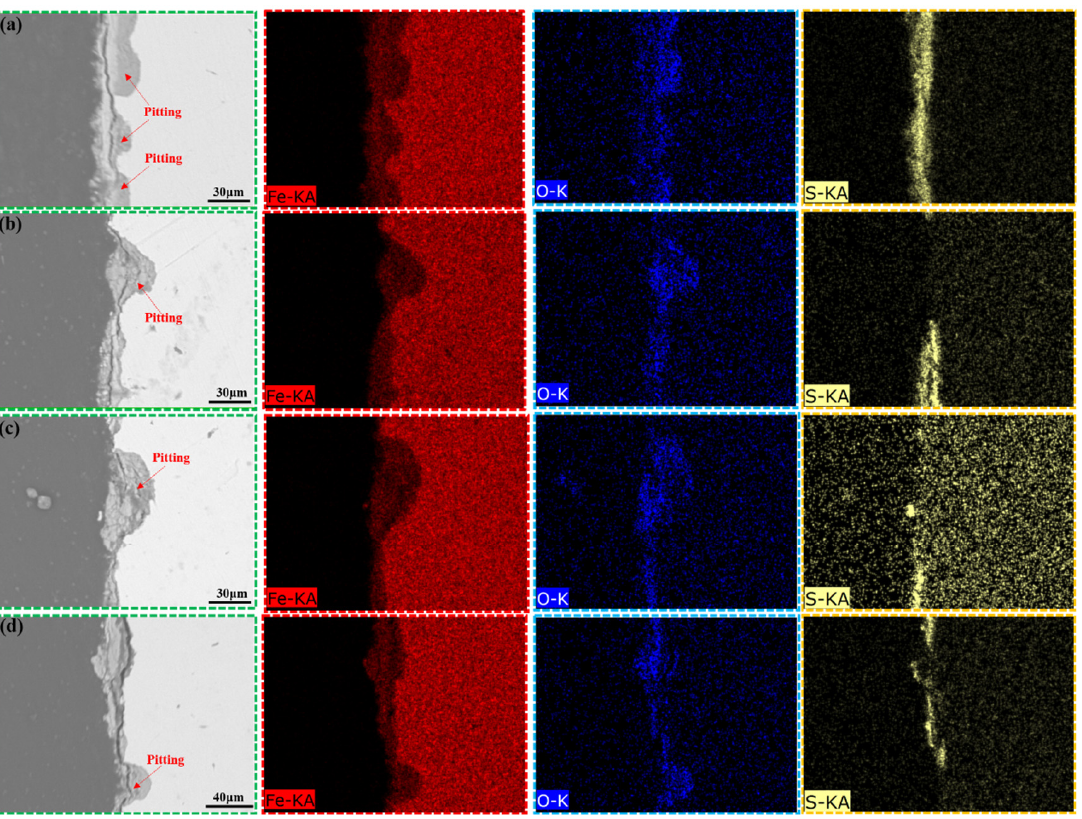
Figure 14. Element distribution in the pitting of T95 steel corroded in the liquid phase ( a ‐ d is 60 °C, 90 °C,120 °C,150 °C).